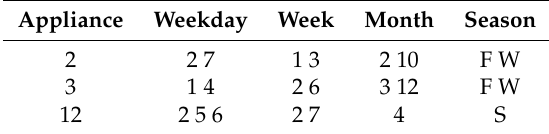
Table 3. Clustering source